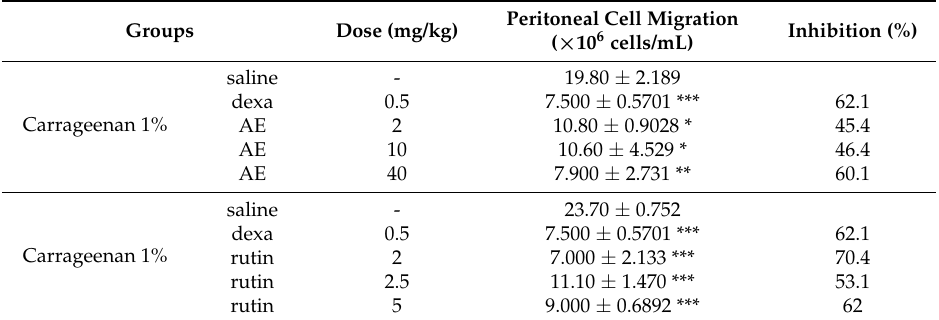
Figure 3. Effect of aqueous extracts from the leaves of Aspidosperma pyrifolium and rutin on inflammation in carrageenan-induced peritonitis model. BALB/c mice were treated intravenously with: aqueous extracts at doses of 2, 10 or 40 mg/kg ( A ); or rutin at doses of 2, 2.5 or 5 mg/mL ( B ), and immediately injected with 1 mL carrageenan 1% intraperitoneal. Dexamethasone (Dexa) at the dose of 0.5 mg/kg was used as positive control intraperitoneal. After four hours, the peritoneal wash was performed with PBS and the number of cells was determined using a Neubauer chamber. *** p < 0.001, ** p < 0.01 and * p < 0.05 when compared to the venom group. Data were analyzed using ANOVA followed by Tukey Test. Dexa: dexamethasone (0.5 mg/kg) and Sal: saline. Table 1. Anti-inflammatory activity of aqueous extract (AE) from the leaves of Aspidosperma pyrifolium and rutin against carrageenan-induced peritonitis model.